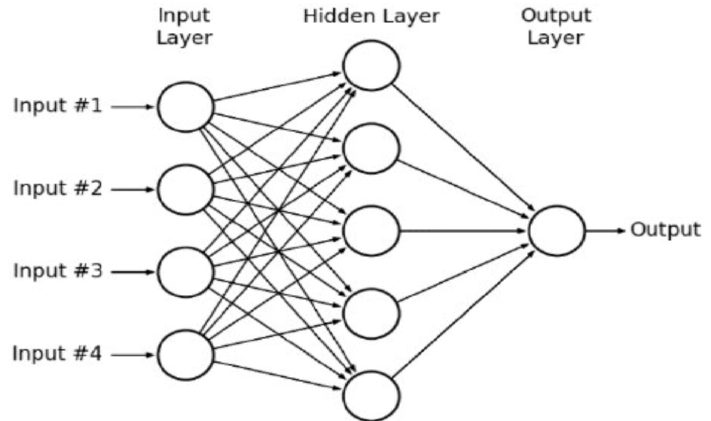
Figure 1. The multilayer perceptron network (MLP) function.